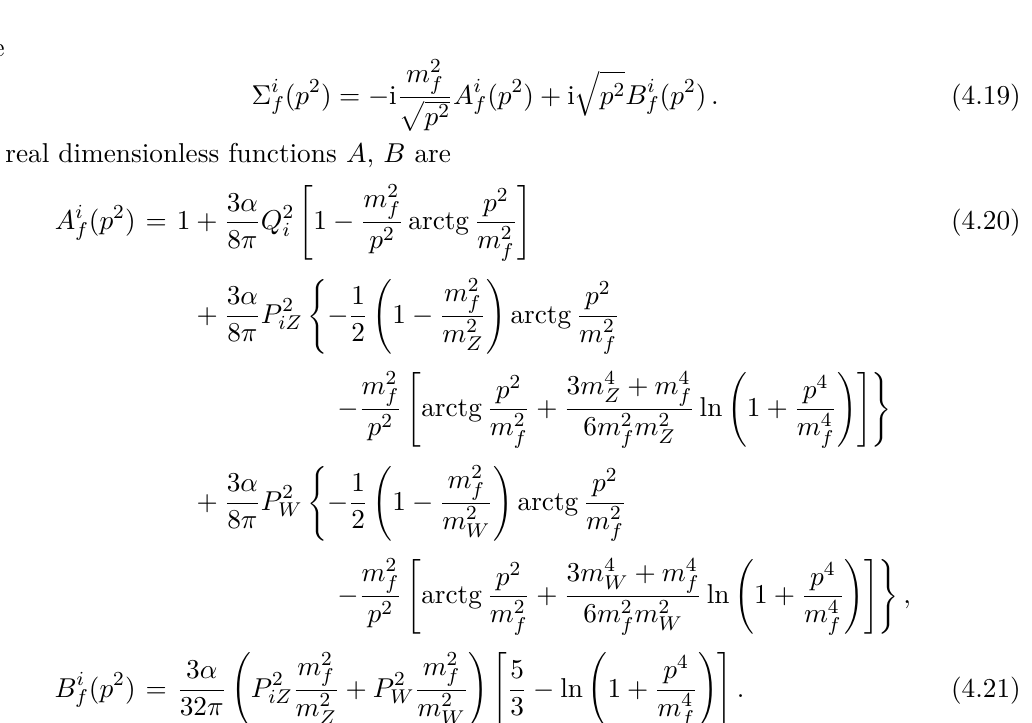
Figure 1 . The lowest-order contributions of new Σ -dependent vertices to the fermion mass splitting in f